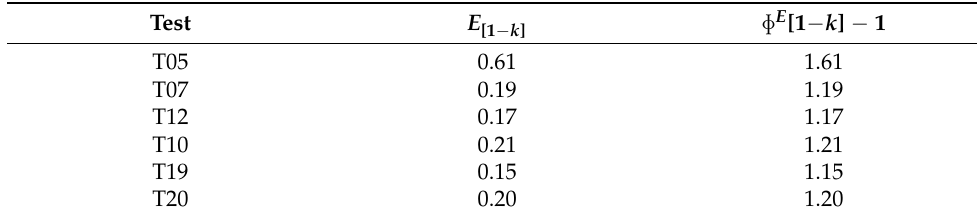
Table 5. Relation of minimum and F when ANN wins.